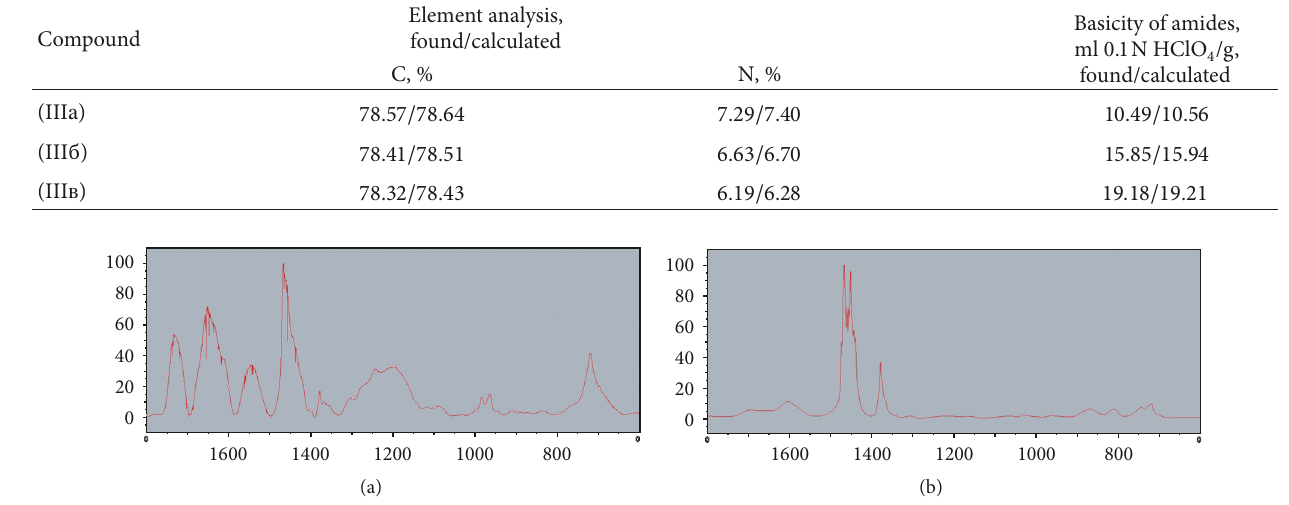
Table 1: Physicochemical characteristics of N-acylated bisimidazolines derivatives (IIIa–III k ).